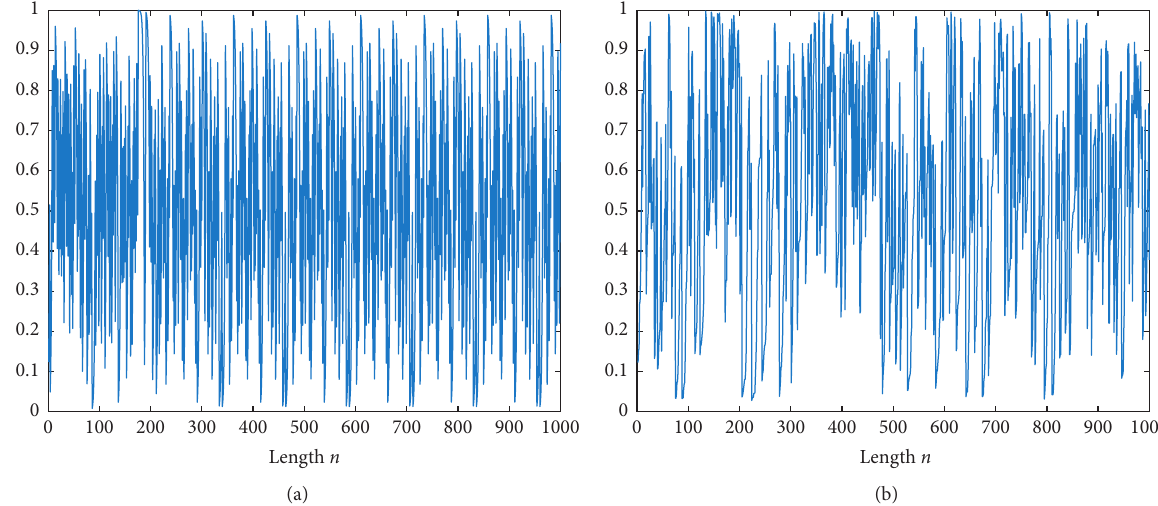
Figure 6: The trajectories of two maps. (a) Digital baker map; (b) digital iteration-time combined baker